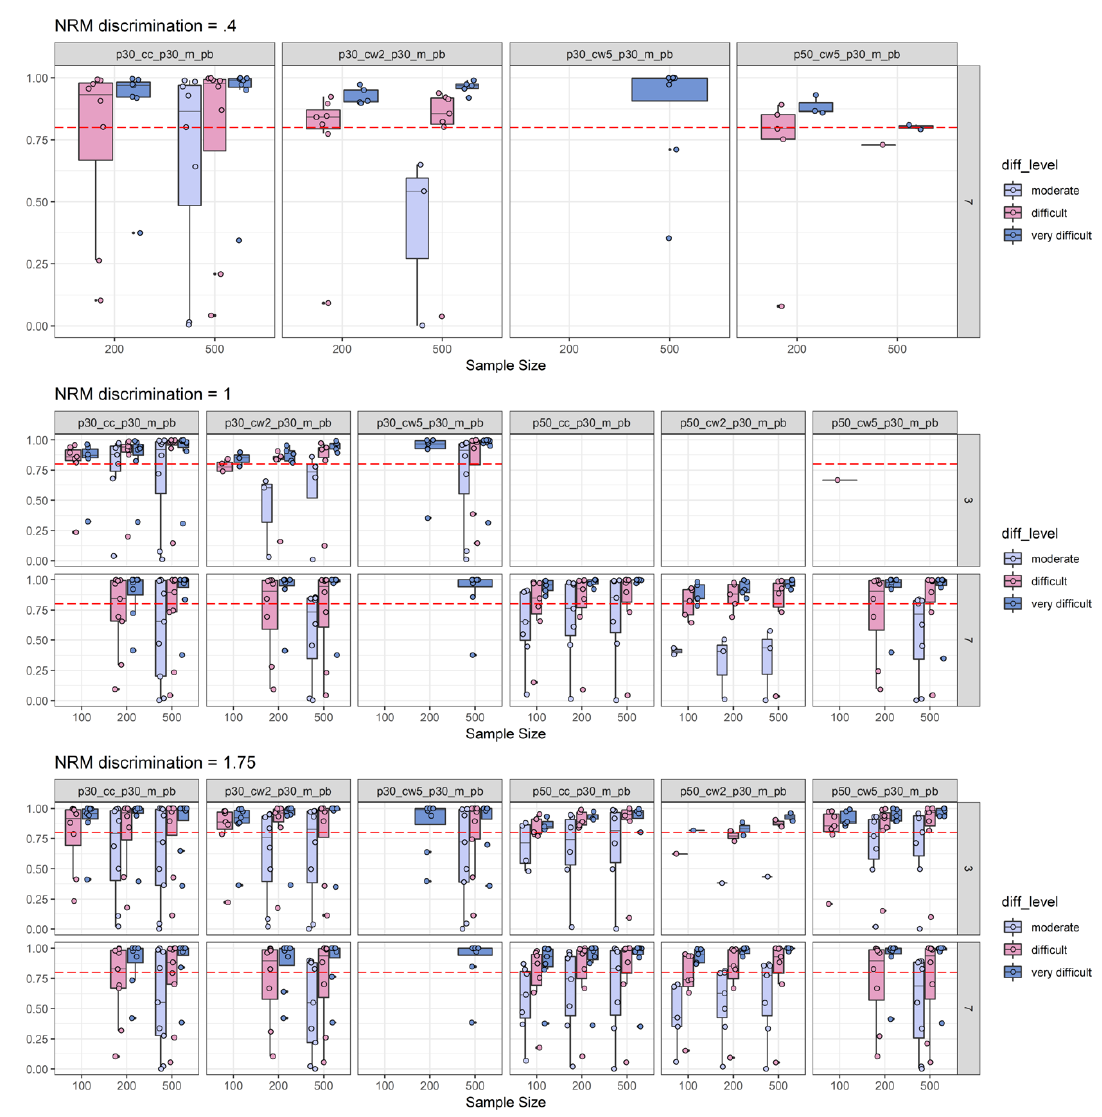
Figure A6. 2PL-difficulty split of empirical power analysis: Depiction of the empirical power (y-axis) under the boundary condition that the average PB DC is smaller than −0.30. Power is depicted as a function of NRM discrimination, sample size (x-axis), number of distractors, 2PL-difficulty, and discrimination effect sizes combined with effect size thresholds. The horizontal red dashed line represents the target power level of 0.80. For more explanations, see Figures 2 and 3.